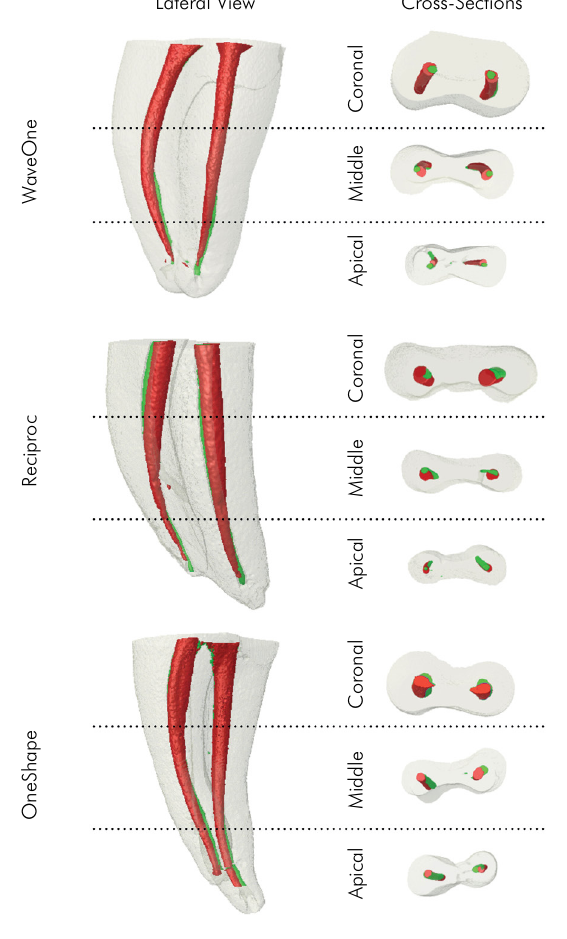
Figure 2. Lateral view of representative 3-dimensional reconstructions of the internal anatomy of superimposed mesial roots of a mandibular molar in each experimental group before (green) and after (red) canal preparation. Representative cross sections of the superimposed root canals before (green) and after (red) preparation at the coronal, middle, and apical